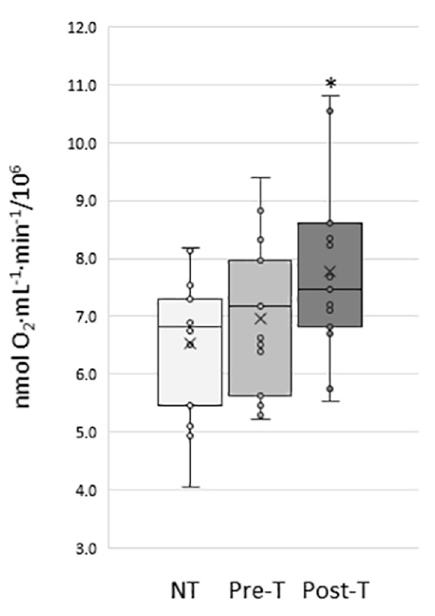
Figure 2. Oxygen consumption, expressed as nmol O 2 · mL − 1 · min − 1 , of cryopreserved sperm that are untreated (NT; n = 25), treated with 20 mg/mL myo-inositol for 20 min before (Pre-T; n = 25), or after (Post-T; n = 25) sperm cryopreservation. Graphical diagrams are plotted as box–whisker plots, where boxes show the interquartile range with median and mean values, and whiskers represent min and max confidence intervals. * p <